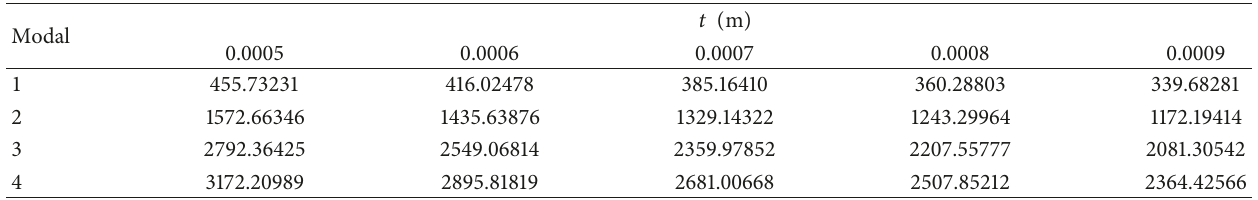
Table 4: Frequencies of different thicknesses of the unit cell.